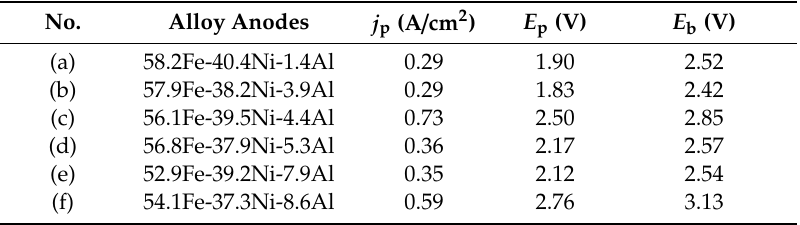
Details of polarization curves for Fe-Ni-Al alloy anodes measured